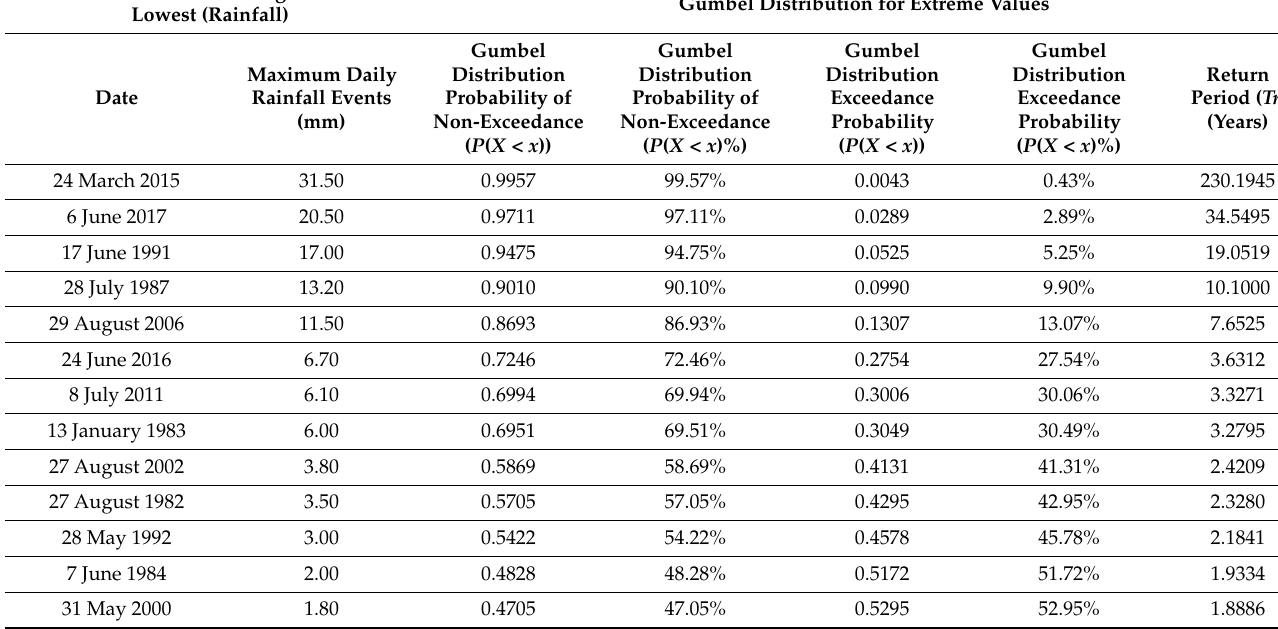
Table 2. Calculation of the probabilities of exceedance, non-exceedance and Return Period ( Tr ) for maximum annual rainfall according to the Gumbel method. A. Years of rainfall: 1978, 1985, 1988, 1990, 1993, 1997, 1998, 1999, 2001, 2003, 2007, 2008, 2010, 2013 and 2018. Tr . Return period, which is inversely proportional to the probability of exceedance ( P ( X < x ) %). Source: Data extracted from the Direcci ó n General de Aguas (DGA)